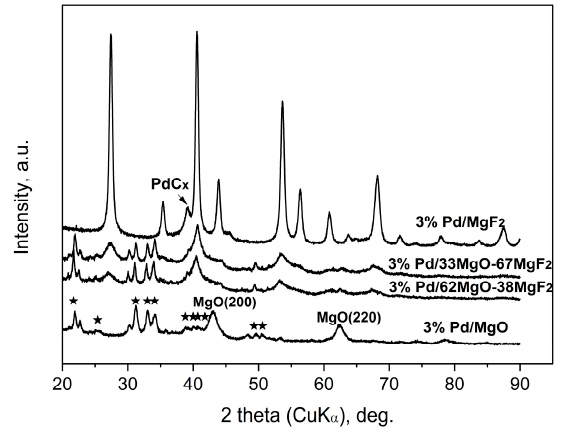
Figure 4. XRD profiles of 3 wt % Pd/MgO-MgF 2 (sol-gel) catalysts after CCl 4 hydrodechlorination. The five-pointed stars show the main reflections of MgCl 2 · 6H 2 O (PDF #760789).